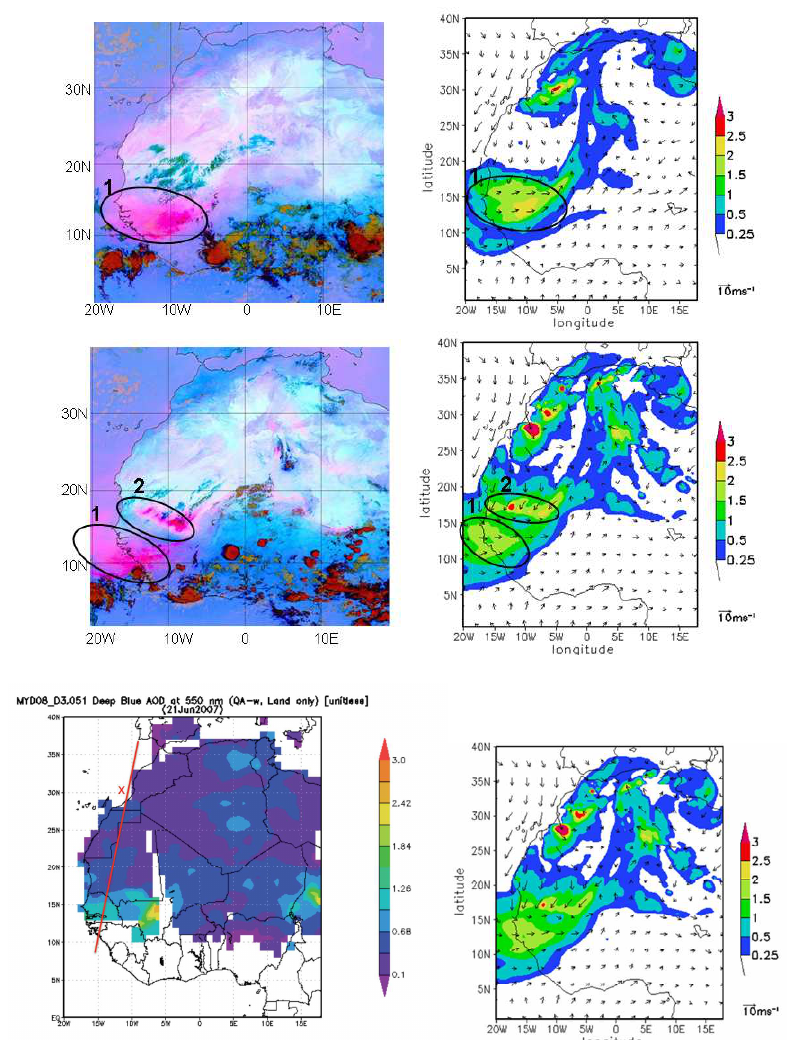
Fig. 7: Simulated AOD at 450 nm and 10 m wind vectors of run F (right) and SEVIRI RGB dust product with dust shown in pink and cold high clouds in dark red (left) on 21 June 2007, 8 UTC (top) and 16 UTC (middle). MODIS deep blue AOD at 550 nm, simulated AOD at 450 nm (run F) and simulated wind vectors at 15 UTC (bottom) .